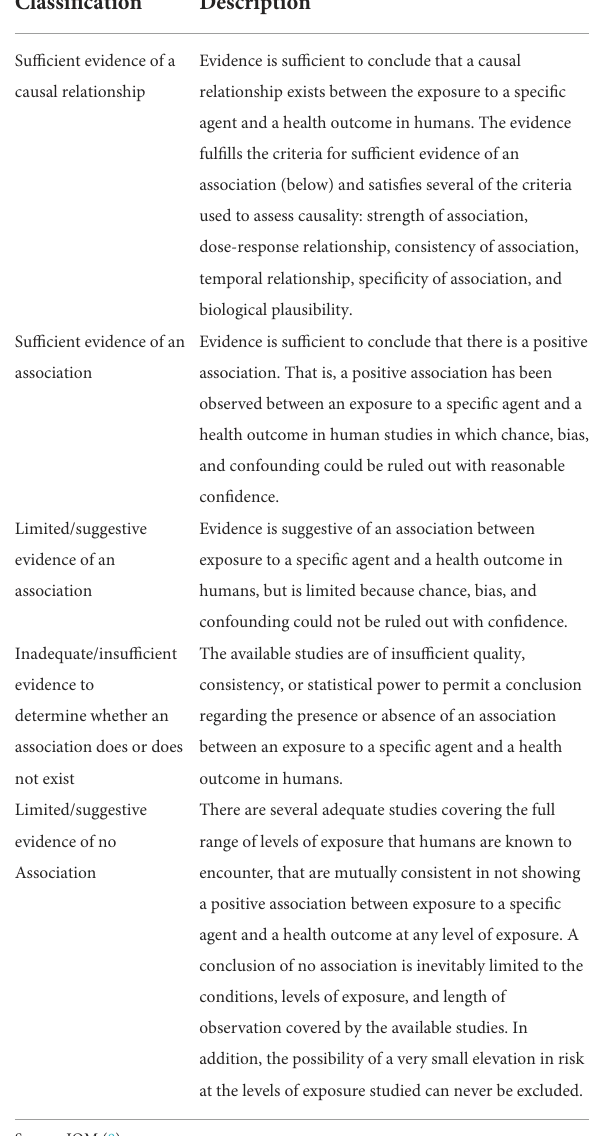
TABLE 1 Categorizations for evaluating strength of evidence a